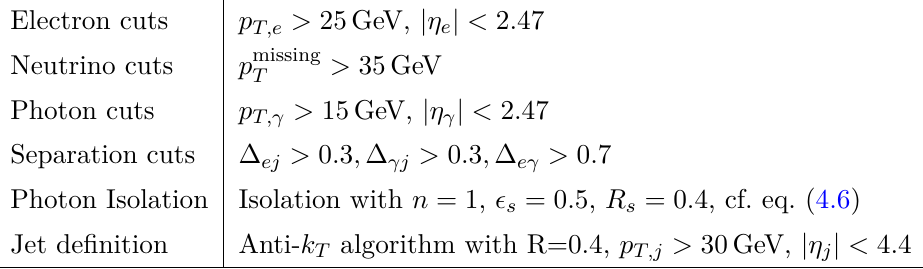
Table 3 . Cuts used for the cross-section results in section